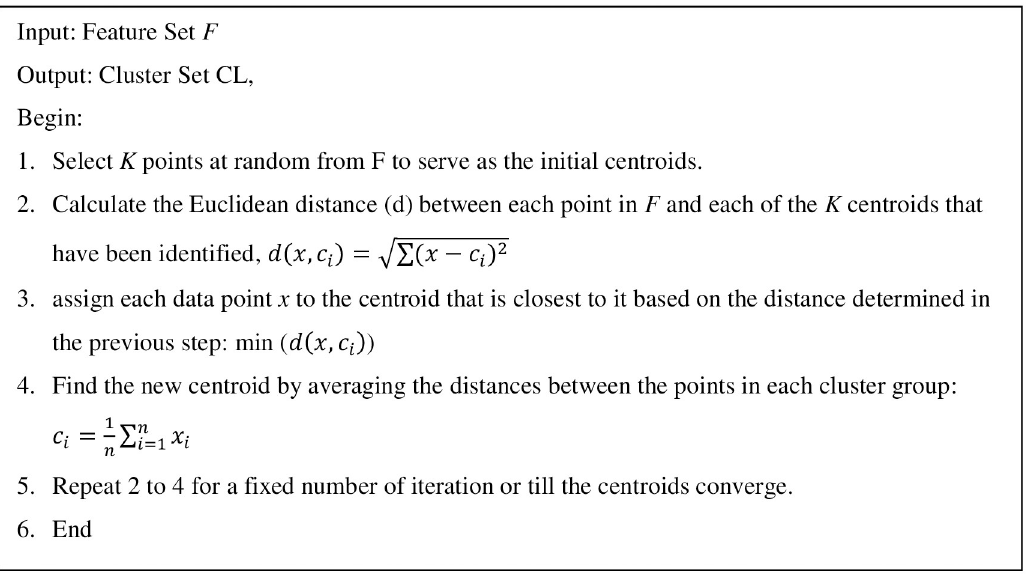
Fig 5. Clustering algorithm (Algorithm I).